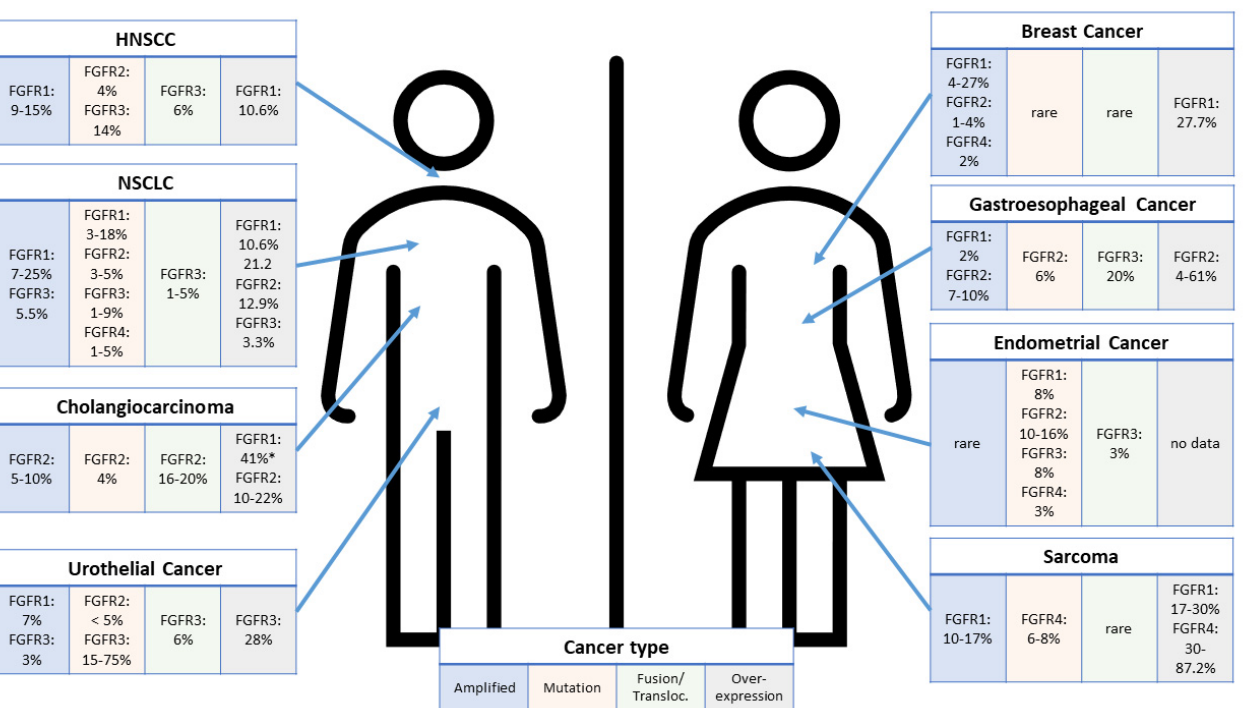
Figure 2. Prevalence of FGFR alterations in selected tumor types. For each tumor type, the prevalence of amplifications, mutations, fusions or translocations and overexpression is highlighted according to [34–40,42–51,113–126]. Overexpression relates to protein overexpression as (usually) detected via immunohistochemistry. FGFR1 data marked with * for cholangiocarcinoma represent mRNA expression data. The most prevalent alteration is depicted in bold for each tumor type. FGFR: fibroblast growth factor receptor; HNSCC: Head and Neck Squamous Cell Carcinoma; NSCLC: Non-Small-Cell Lung Cancer.